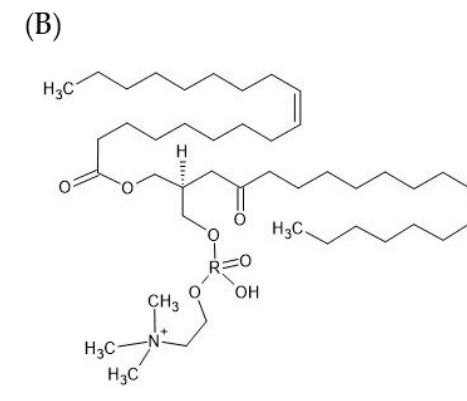
Figure 6. Chemical structure of ( A ) ginsenoside and ( B ) lecithin.